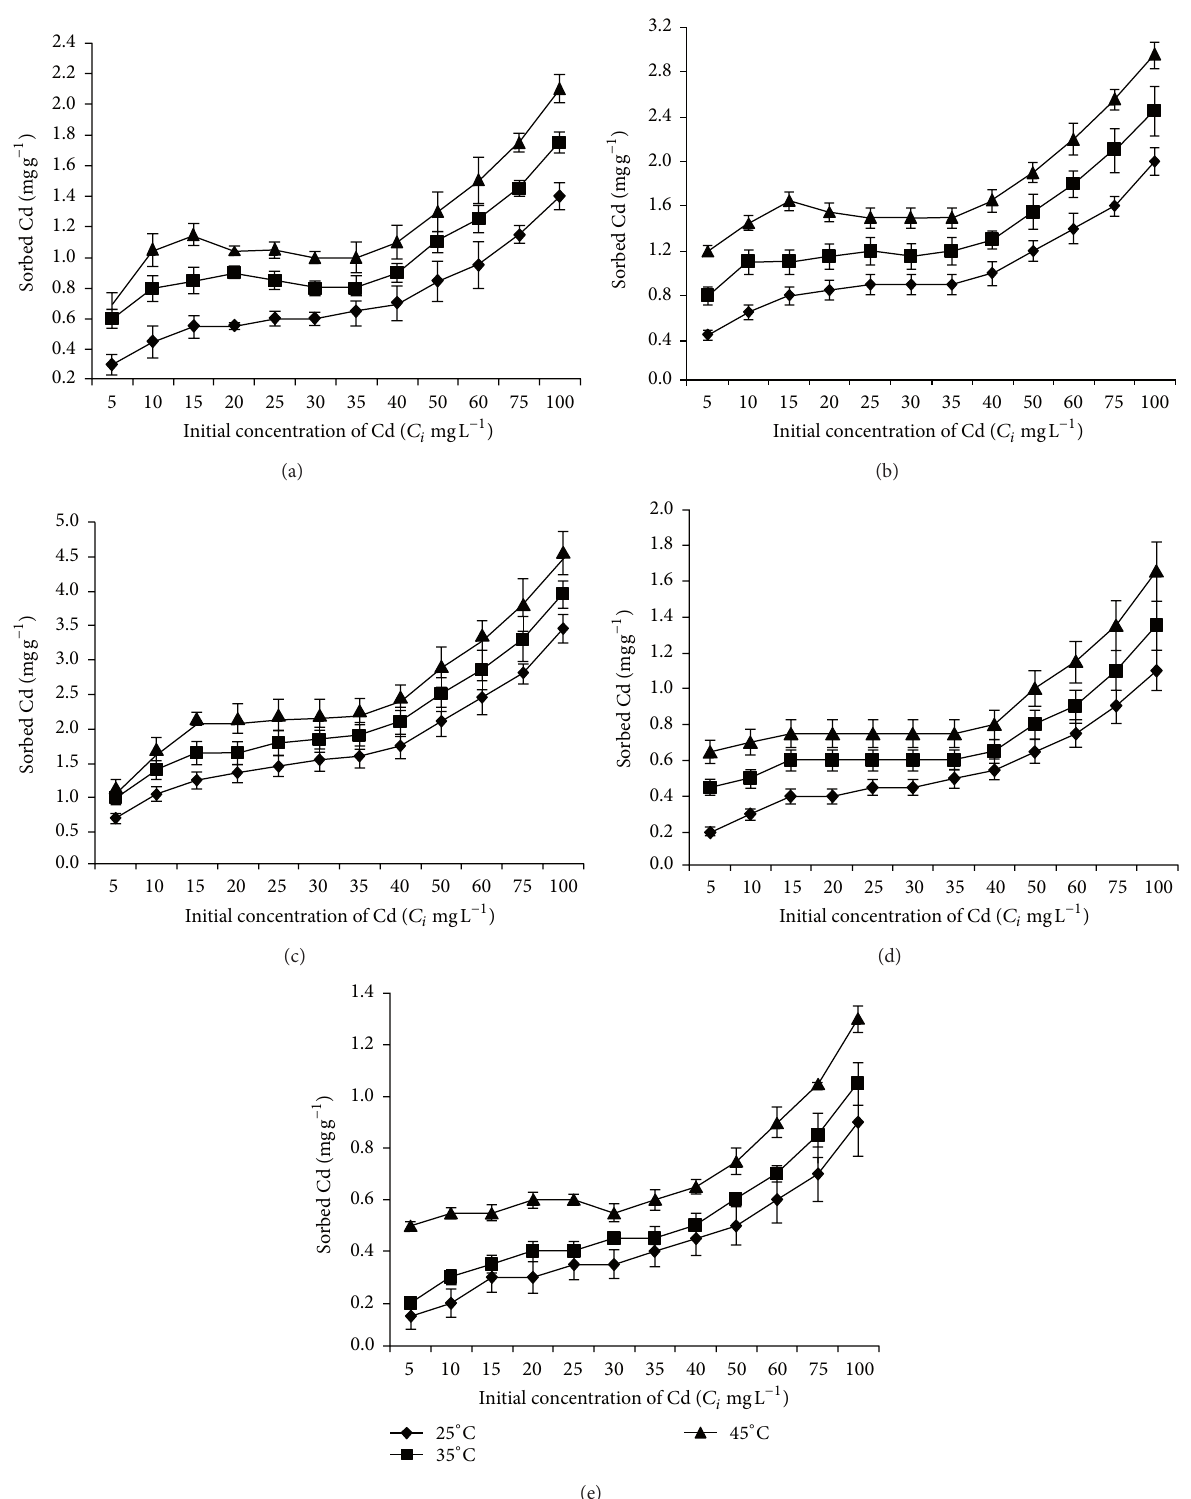
Figure 2: Amount of Cd adsorbed at equilibrium as a function of three different temperatures for the experimental soils [(a) S 1 , (b) S 2 , (c) S 3 , (d) S 4 , and (e) S 5 ] at different Cd